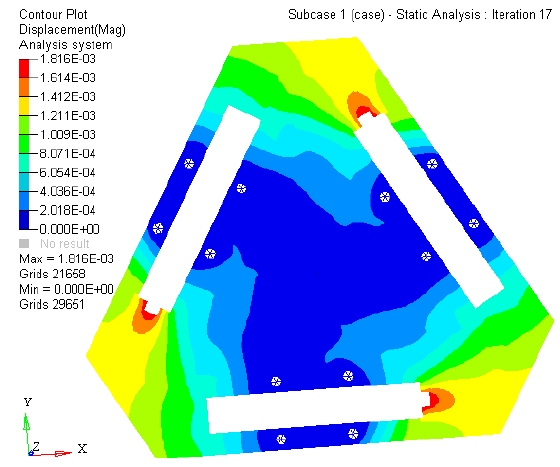
Figure 7. The stress distribution with the prototype of 3-PRR planar fully CPMs.